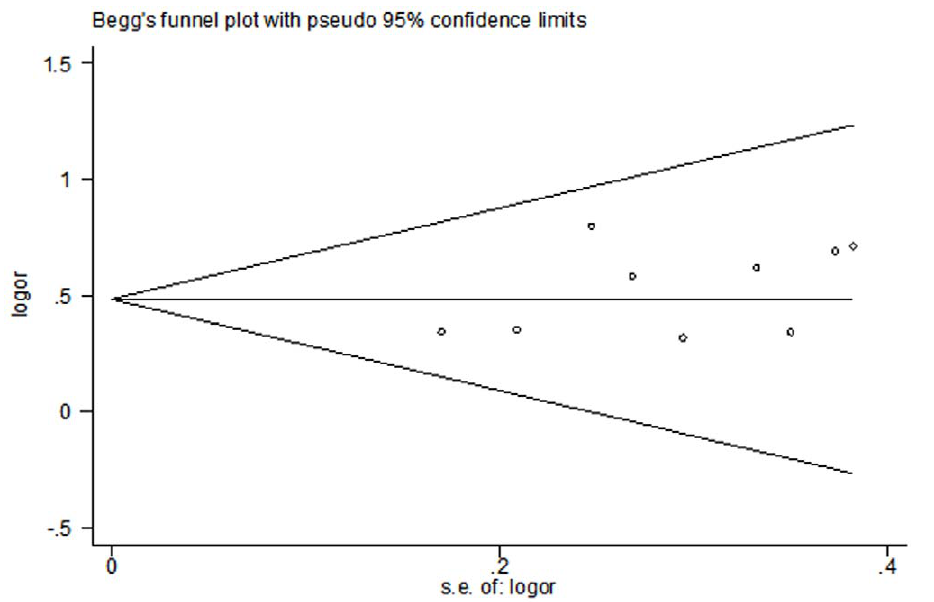
Figure 3. Begg’s funnel plot for publication bias in selection of studies on the PAI-1 4G/5G polymorphism (4G4G + 4G5G vs. 5G5G).